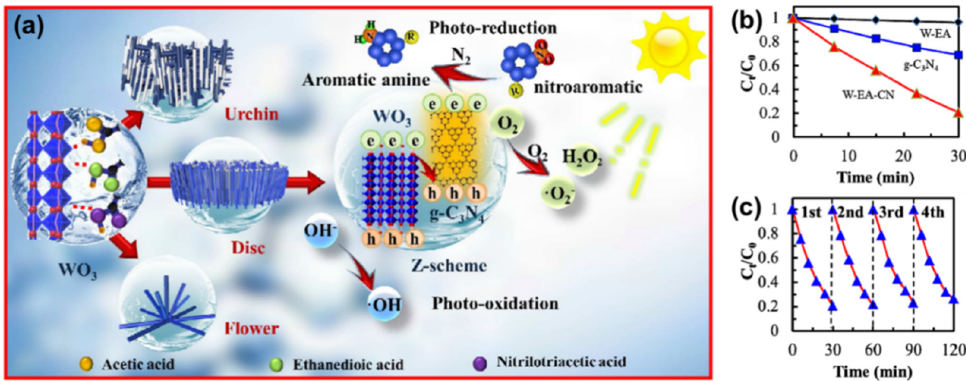
Figure 19. ( a ) The mechanism of organic acid inducing the growth of WO 3 with different shapes and the photocatalytic process occurring over g − C 3 N 4 /WO 3 ; ( b ) photocatalytic activity of different samples; and ( c ) recycle stability for the reduction of Cr(VI) and (m) cyclic experiments of W − EA − CN for photoreduction of Cr(VI). Used with permission from [188]. Copyright 2012 Royal Society of Chemistry.